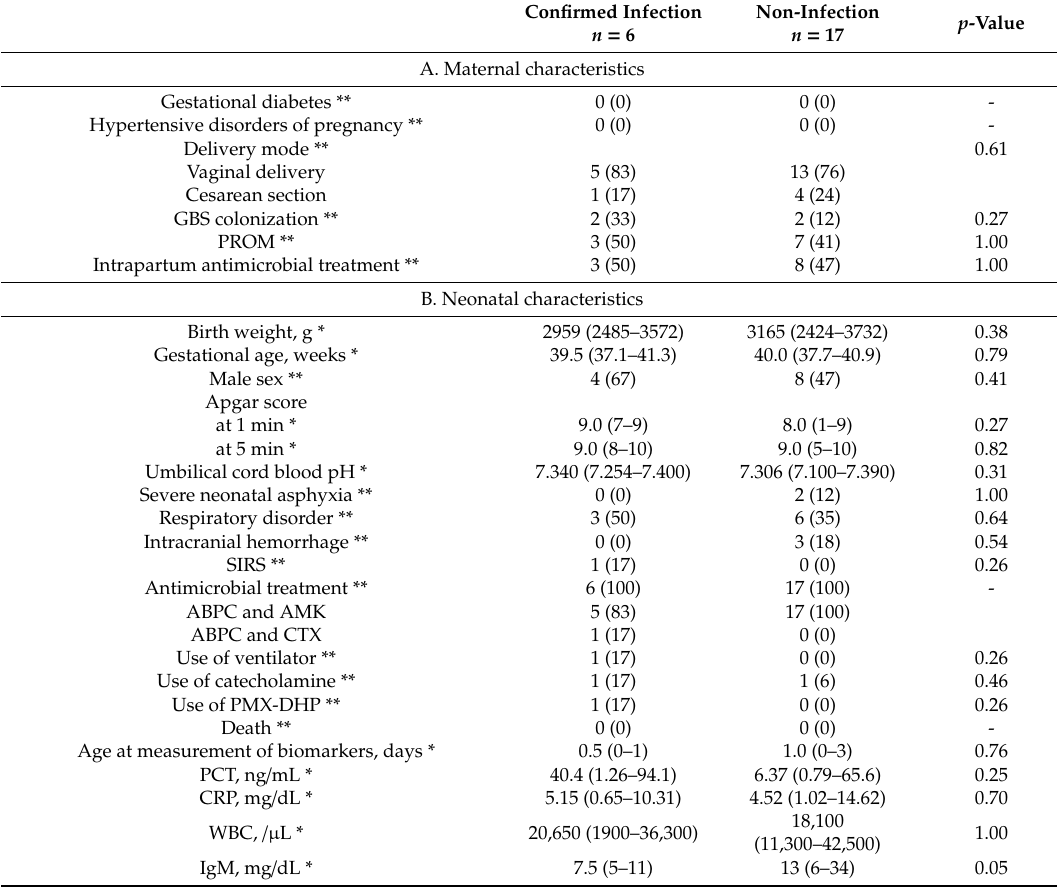
Table 3. Distribution of clinical characteristics among term